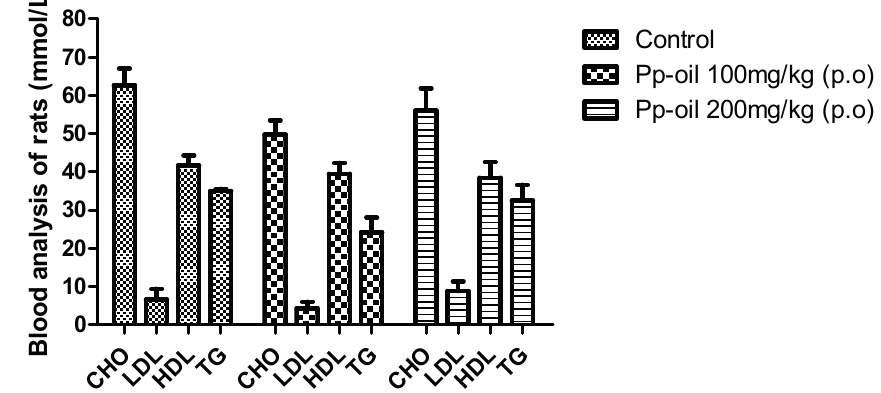
Figure 1. Clinical chemistry results for oral doses of 100 mg/kg and 200 mg/kg compared with control. Values are mean ± S.E.M (s.e.m.) and abbreviations: CHO, total cholesterol;